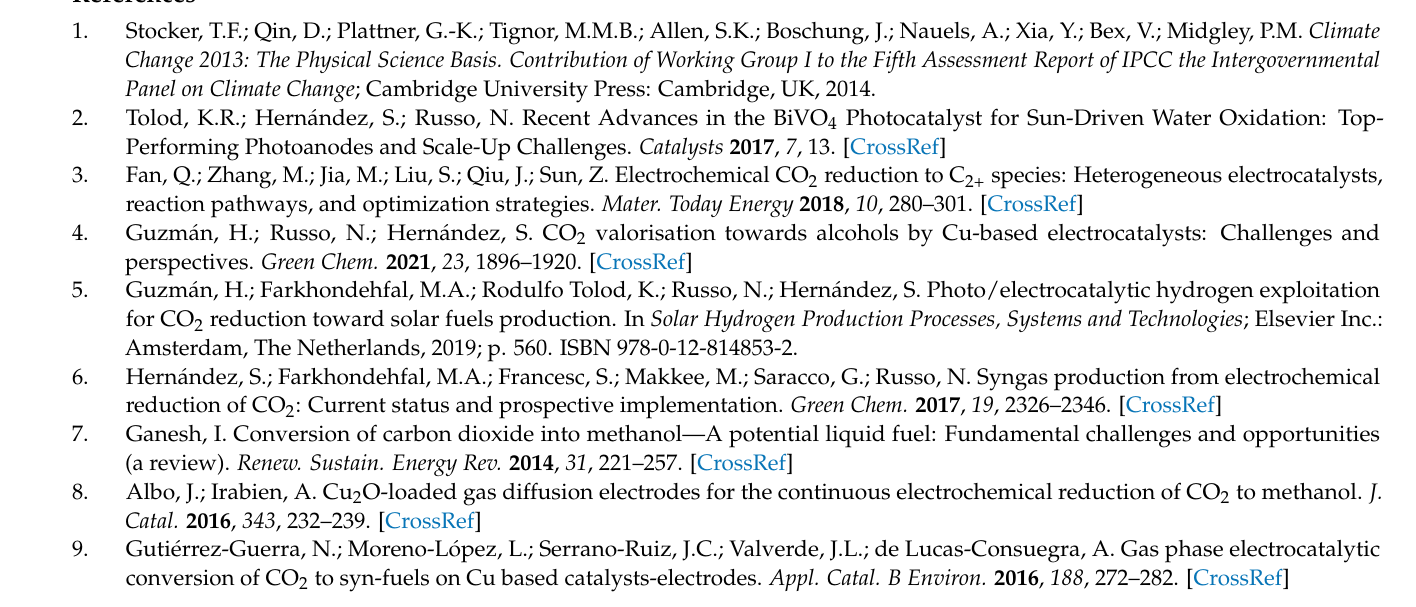
tion/desorption isotherms of the prepared CuZnAl-oxide based samples. Figure S3: Additional TEM results for samples Cu-06, CuZ-06-03, and CuZA-06-03-01. From left to right, the analy- sis consists of a representative Bright-field TEM image of a specific region of the sample, the corresponding electron diffraction pattern, and the average EDS spectrum obtained over the whole region. Figure S4: High-angle annular dark field (HAADF) scanning transmission electron microscopy image (left) with the corresponding EDS elemental maps (right) for Cu, Zn, Al, and O elements in the CuZA-06-03-01 sample. Figure S5: XRD patterns of CuZA-06-03-10 electrodes: Fresh (a), tested at − 12 mA cm − 2 (b) and tested at − 24 mA cm − 2 (c). Figure S6: Cyclic voltam- metry responses for the CuZA-06-03-01 electrode in a traditional three-electrode cell in a CO 2 saturated 0.1 M KHCO 3 solution at different scan rates. Figure S7: XPS Cu2p HR spectra of CuZA- 06-03-10 electrodes: Fresh (black), tested at − 12 mA cm − 2 (red) and tested at − 24 mA cm − 2 (green). Table S1: Analysis of the selected area electron diffraction patterns reported in Figure S3 and in Figure 6 in the manuscript. Table S2: The table shows the percentage of oxidation states of copper and Auger parameter values calculated for CuZA-06-03-10 electrodes and the related average oxidation